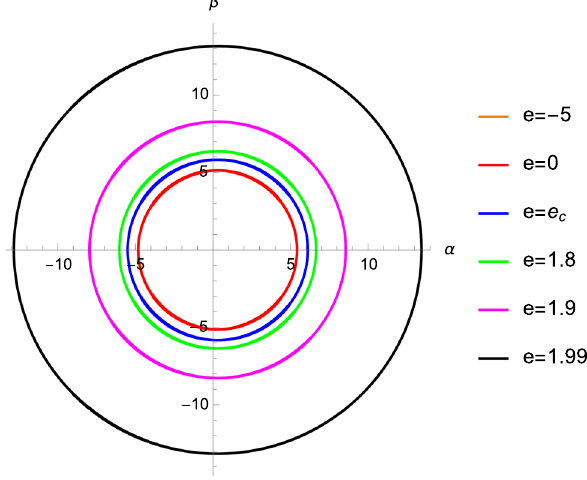
Fig. 3 This figure shows the shadow corresponding to metric (Eq.1) if used to model M 87 ∗ BH shadow ( M = 1) for a ∗ = 0 . 5 and dif- ferent values of e . Beyond a critical value e > e c ≈ 1 . 75, the shadow size becomes bigger than 45 μ as and becomes inconsistent with